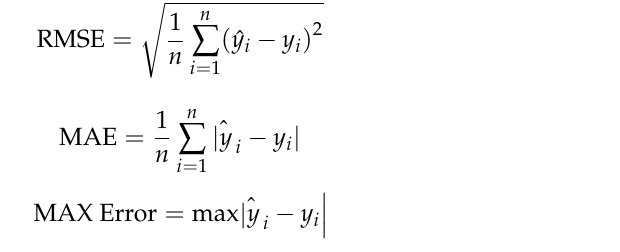
Figure 7. SOC estimation results and errors under FUDS at 10 °C. ( a ) Comparison of SOC estimation results under FUDS at 10 °C; ( b ) comparison of SOC estimation errors under FUDS at 10 °C.